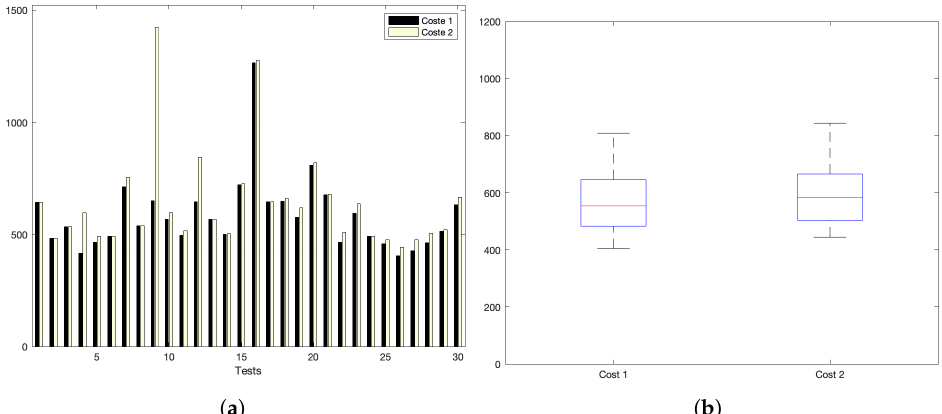
Figure 6. Med–low request-rate scenario: ( a ) individual test values for cost 1 and cost 2 ; ( b ) summary values.